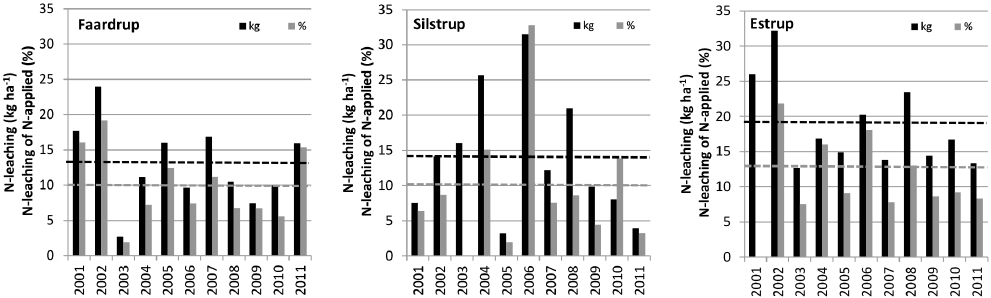
Figure 7. Nitrate-N in drainage in mass (kgNha − 1 ) and of applied N (%) (inorganic N fertilisers plus slurry) for the years 2001 to 2011 at Faardrup, Silstrup and Estrup. The black dashed line indicates the average annual N-leaching in 2001–2012 and the grey dashed line is the average nitrate-N leaching of applied N in